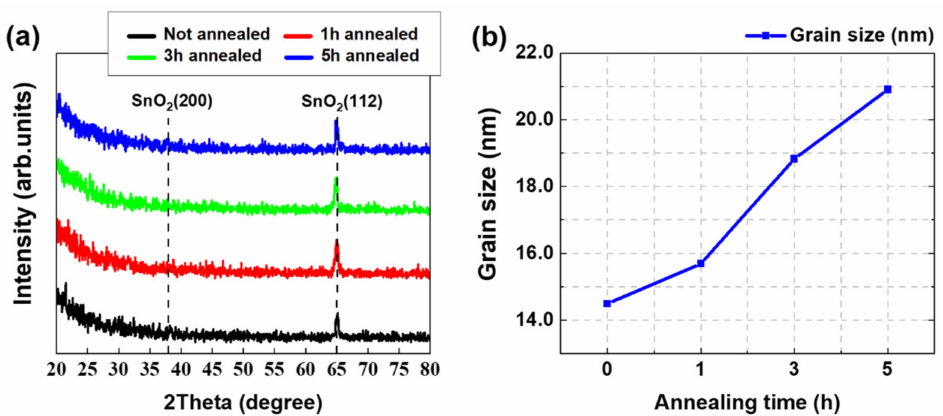
Figure 3. ( a ) XRD of SnO 2 for annealing time; ( b ) average grain sizes of the SnO 2 thin film with annealing